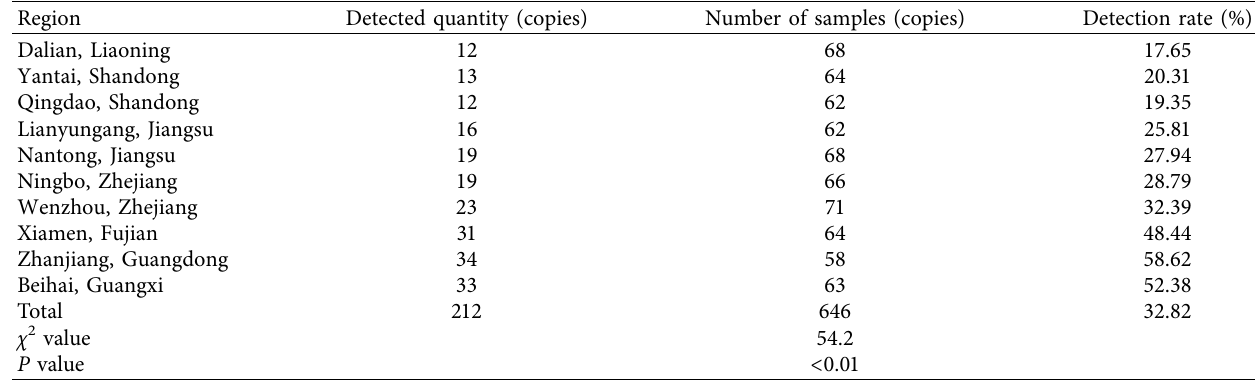
Table 4: Detection level of pathogenic Vibrio in aquatic products in different regions.